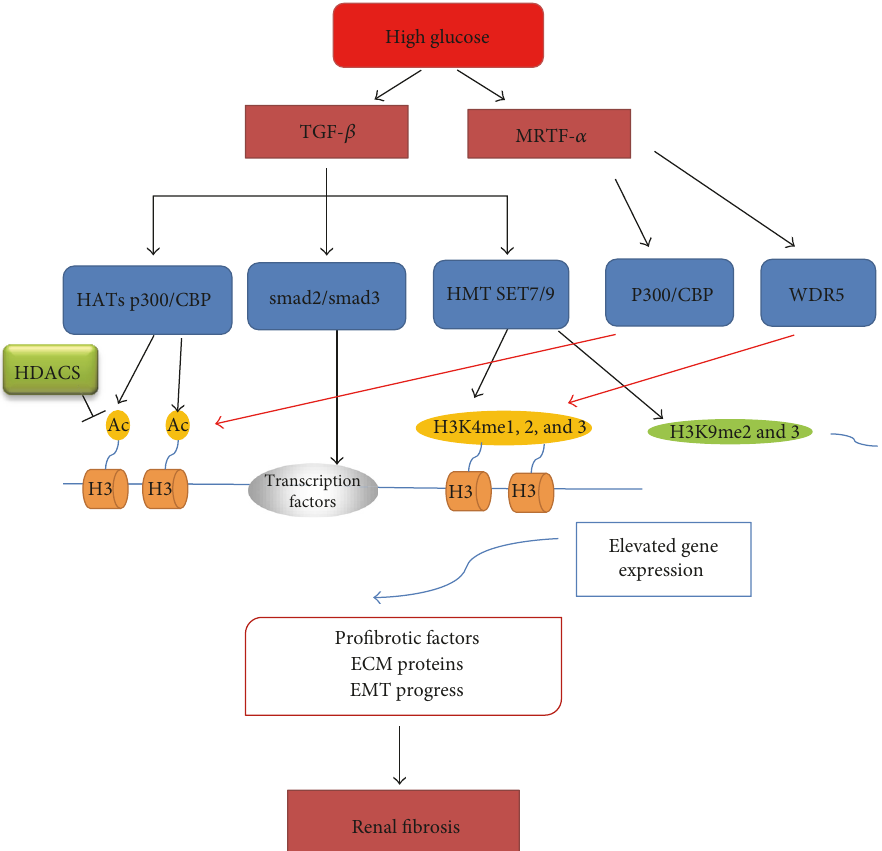
Figure 2: Histone modi fi cations regulate gene transcription involving renal fi brosis of diabetic kidney disease. TGF- β signaling pathway, activated by high glucose, will stimulate two types of epigenetic histone mechanisms including histone acetylation and histone methylation. TGF- β 1 activates the histone acetyltransferase (HAT) p300/CBP, followed by the enrichment of H3K9/14Ac and HAT p300/ CBP at the promoters of renal fi brotic genes, and then increases the transcriptions of fi brotic genes and EMT progress. After induced by TGF- β 1, the methyltransferase SET7/9 enriches at fi brotic gene promoters, leading to increases of positive chromatin marks, such as H3K4me1, H3K4me2, and H3K4me3, and reductions of inhibitive marks including H3K9me2 and H3K9me3, at promoters of fi brotic genes. Eventually, the expressions of renal fi brotic genes are upregulated, which will result in the progression of DKD. Another pathway, myocardin-related transcription factor A (MRTF-A), also can be activated by high glucose. MRTF-A can regulate the histone acetylation and histone methylation of renal fi brotic genes by accelerating the recruitment of HAT p300/CBP and HMT WDR5 to fi brotic